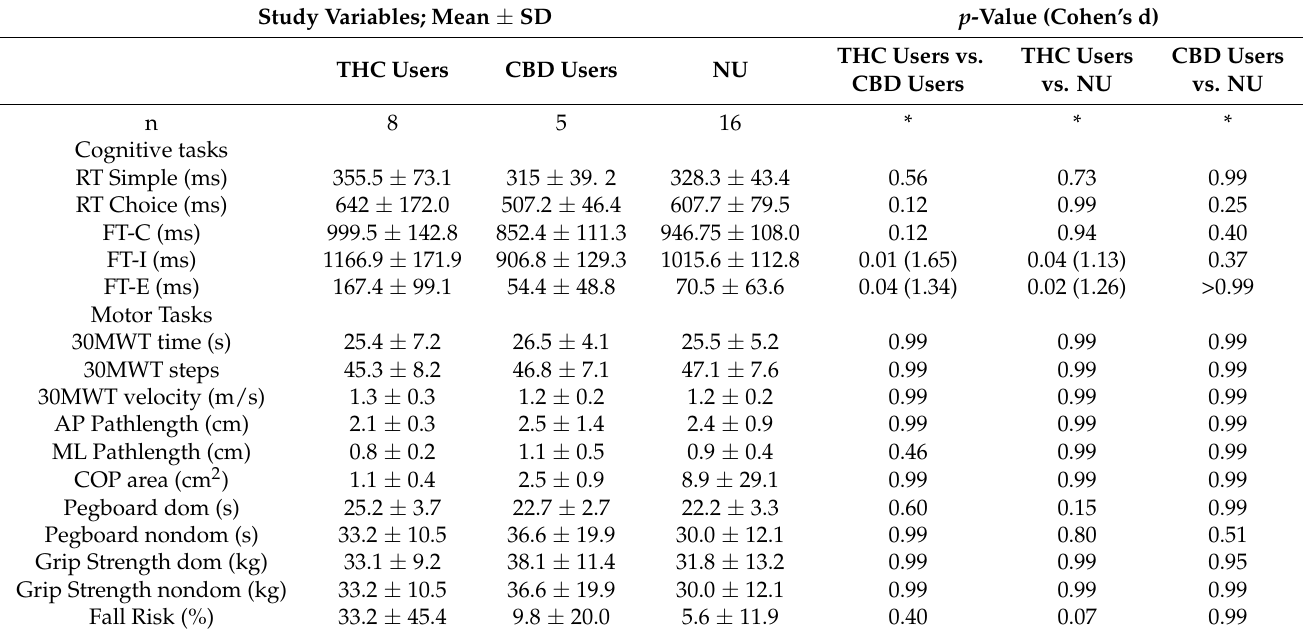
Table 2. Summary data for motor outcomes and the results of post-hoc t -tests comparing each group.